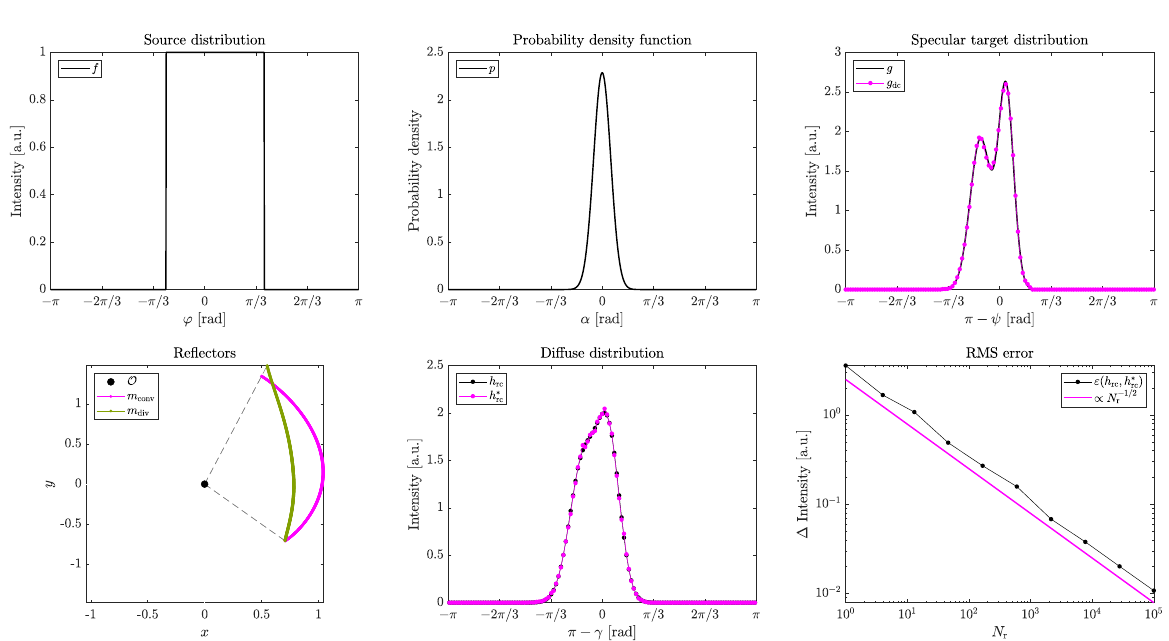
Figure 4. Example of cylindrically symmetric reflector design procedure. The prescribed di ff use distribution h is achieved, and the raytraced distribution converges with the expected square-root behaviour.